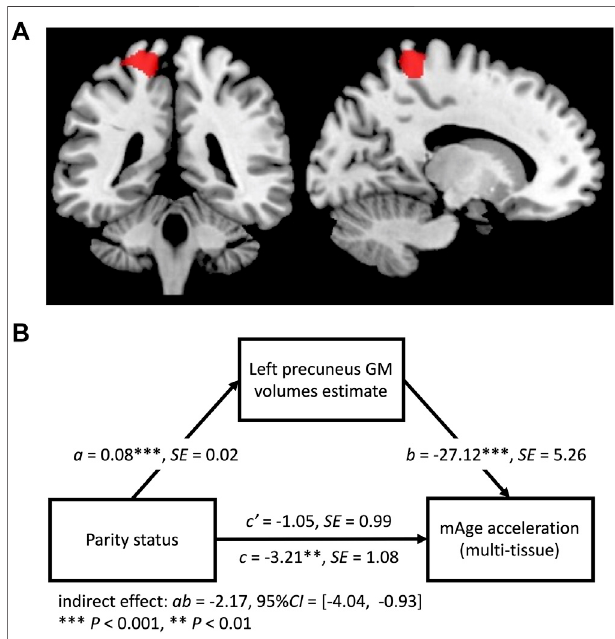
FIGURE 2 | (A) Regions of gray matter (GM) volume negatively associated with mAge acceleration (red; threshold p < 0.05, family-wise error corrected cluster level). (B) Path model for the mediation effect. GM volumeof the left precuneus was a mediator in the relationship between parity status and mAge